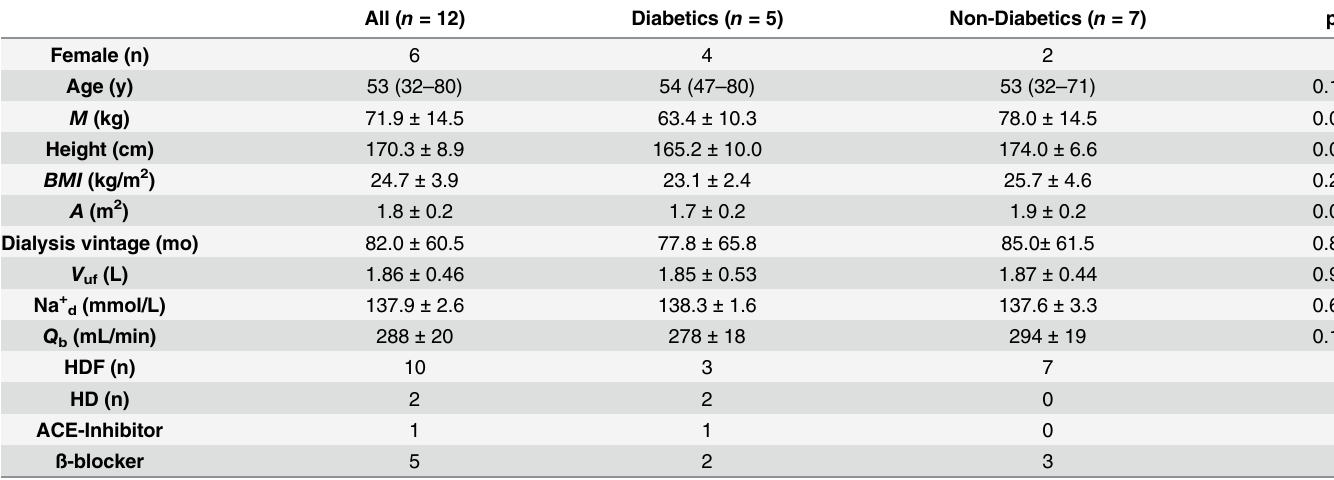
Table 1. Patient and treatment